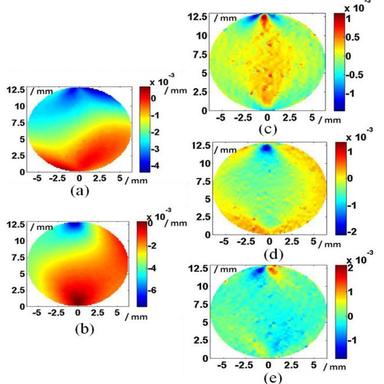
Displacement fields along (a) the x axis and (b) the y axis, and strain fields (c) ɛxx, (d) ɛyy, and (e) ɛxy.